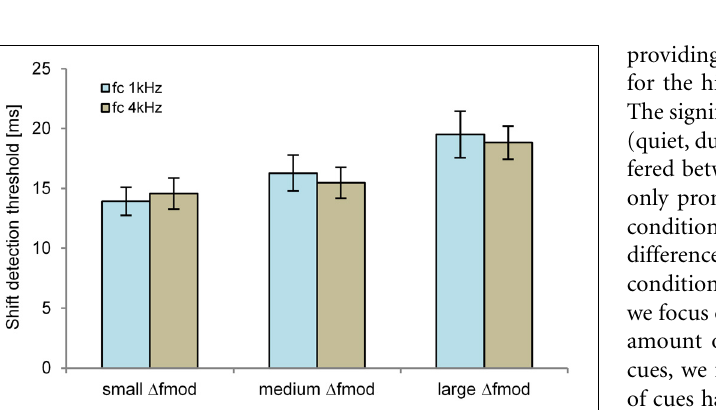
FIGURE 6 | Proportions of a 2-stream percept (mean and s.e.m.) are shown for the f c of 1kHz (blue) and 4kHz (brown) for the measurements in quiet (lighter coloring: n = 6) and during fMRI (darker coloring: n = 9) for all (cid:2) f mod conditions.